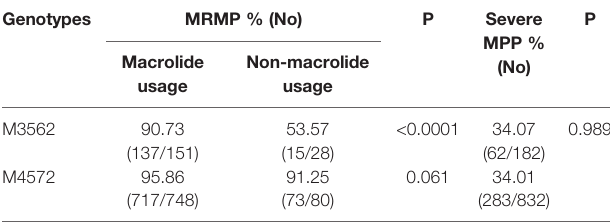
TABLE 3 | The in fl uence of prehospital macrolide usage on drug resistance and the distribution of severe MPP within M4572 and M3562 types *.